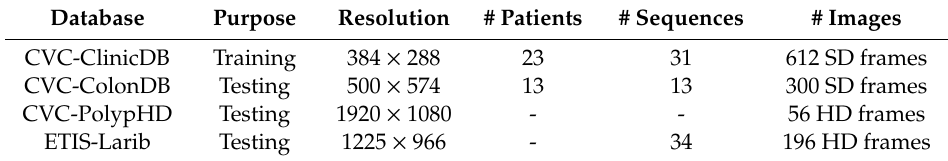
Table 1. Summary of colonoscopy